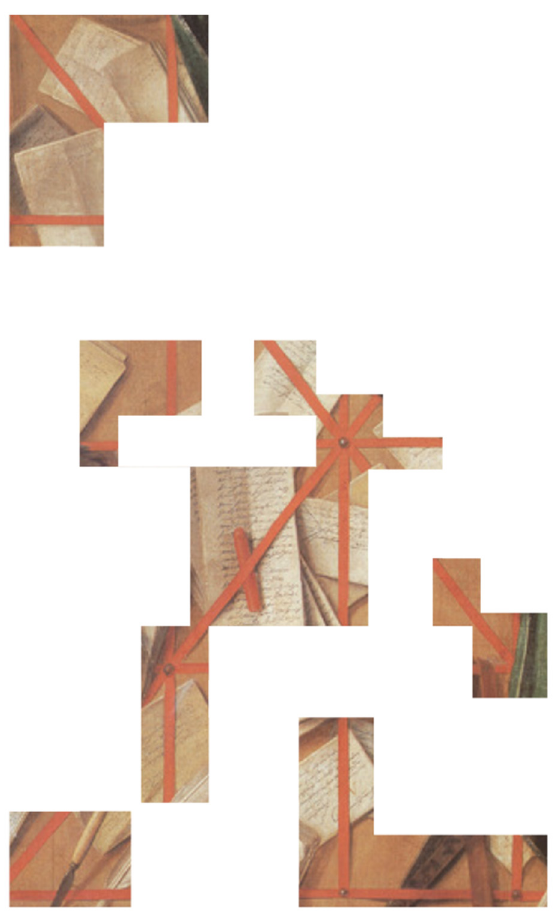
Figure 10. Red ribbon, detail (Gijsbrechts 1664, see Figure 5).